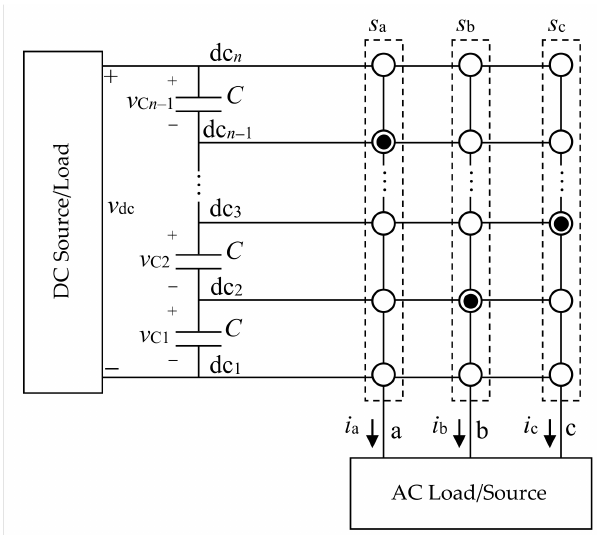
Figure 4. Multilevel three-phase NPC DC–AC conversion